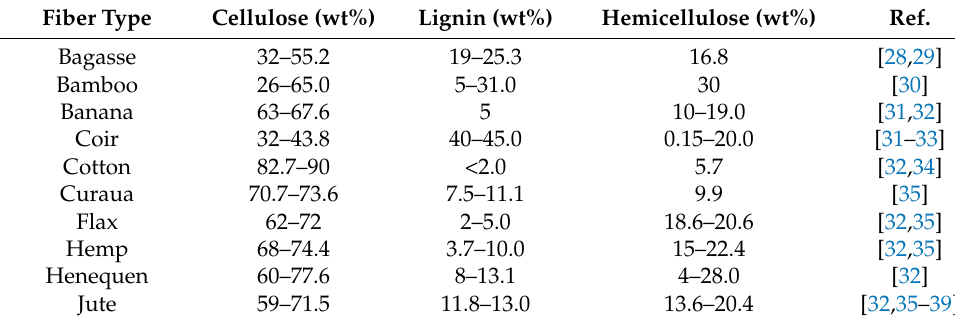
Table 2. Chemical composition of natural fibers.